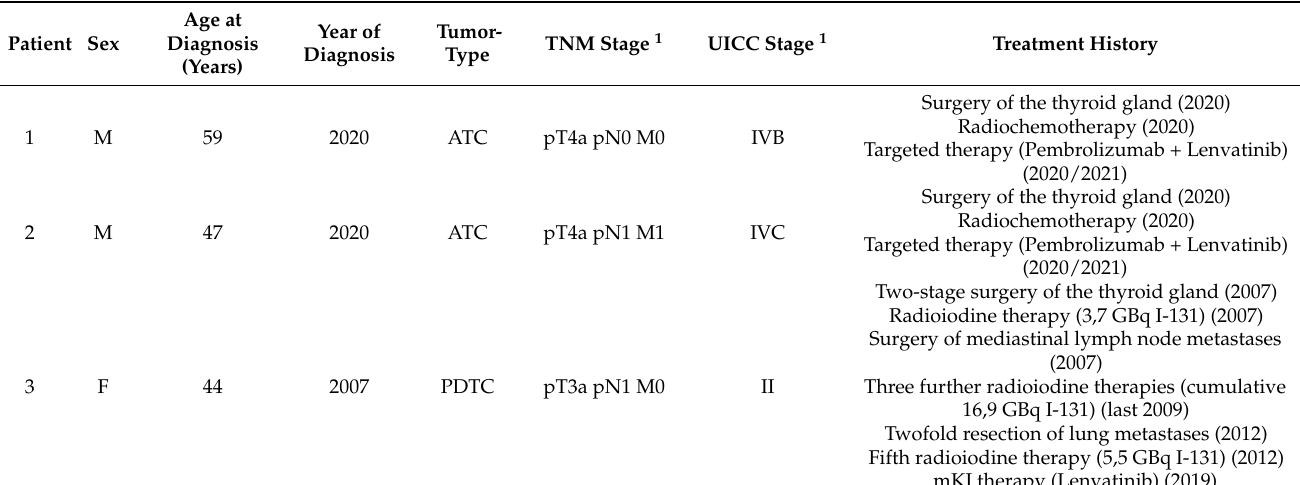
Table 1. Patients ´ characteristics at initial